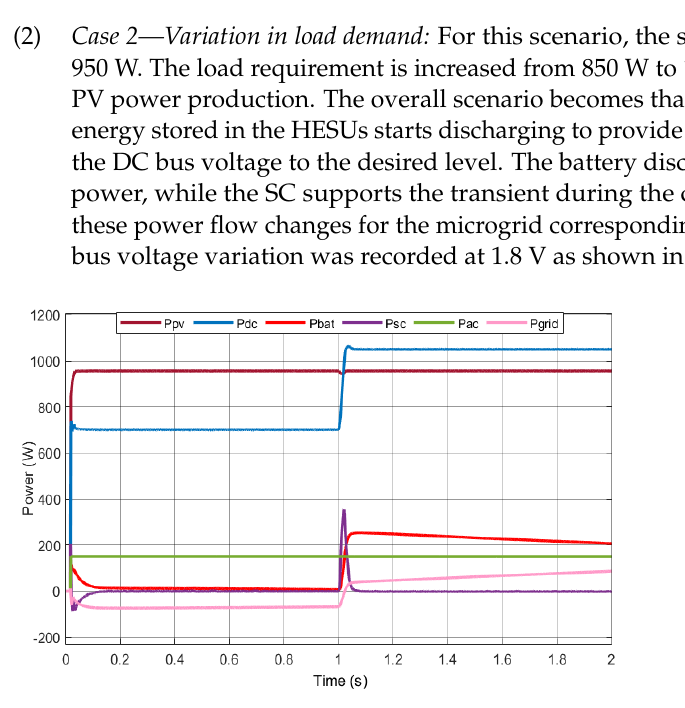
Figure 14. Dc link voltage with PV variation.